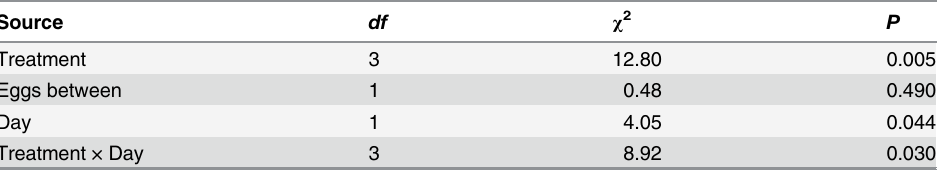
Table 1. Generalized linear model of the effects of different male reproductive organ — derived ex- tracts (treatment) and the number of days in between matings (days) on the sperm competitive suc- cess of the second male in double mating experiments (N = 29 – 42 females per day and treatment group).